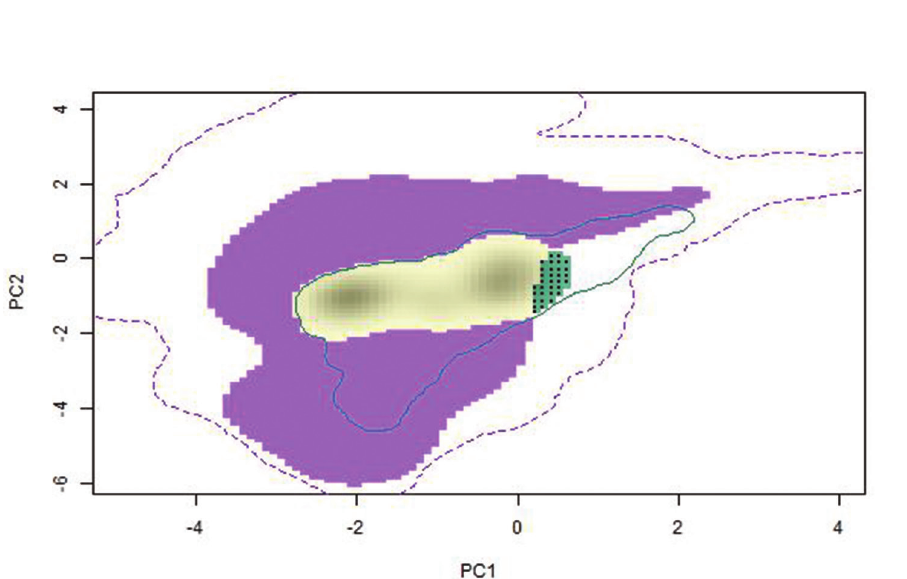
Figure 3. Similarity of environmental niches in the Americas and Africa. The outlines represent the environmental conditions available in the Americas (purple, solid line) and Ghana and Zambia (green, dashed). The larger purple shaded area represents the conditions the species occupies only in the Americas. The yellow shaded areas represent the conditions the species occupies in the studied African range that lie within the American environmental niche (niche stability). The green area with dots shows the part of the African range that is found in different environmental conditions to the native range (niche expansion). The shading under the yellow/green area is the density of the species’ occurrence in the African